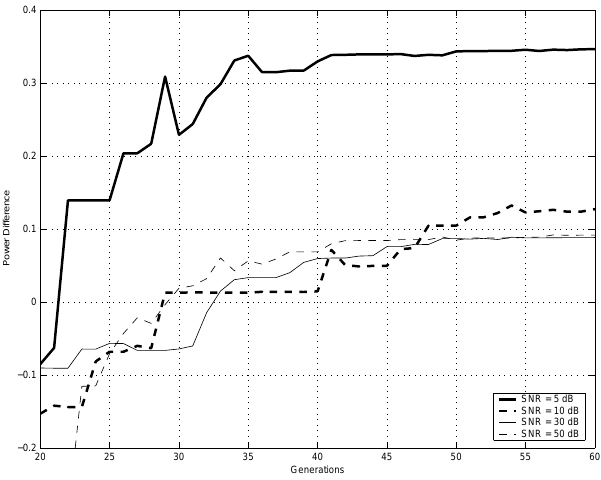
Fig. 7. Fourier power difference convergence for different SNR scenarios. Fourier power difference is obtained by subtracting the total Fourier power for each generation from the total Fourier power without